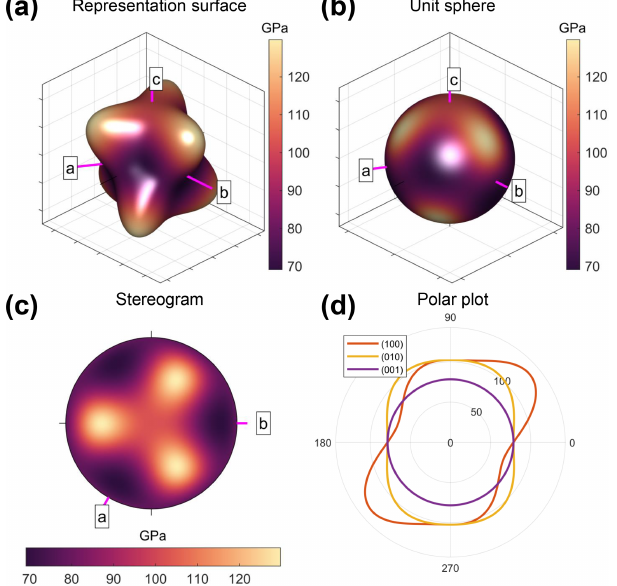
Figure 4. Alternative visualisations of the anisotropy of Young’s modulus ( E , in GPa) of α -quartz. (a) 3D representation surface where the radius in any direction is proportional to the magnitude of E . (b) Projection of E on to a unit sphere, colour-coded by magnitude. (c) Lower-hemisphere equal-area stereographic projec- tion. (d) Polar plot of anisotropy of E in selected planes. Crystallo- graphic axes (cid:104) a (cid:105) , (cid:104) b (cid:105) and (cid:104) c (cid:105) shown in pink.